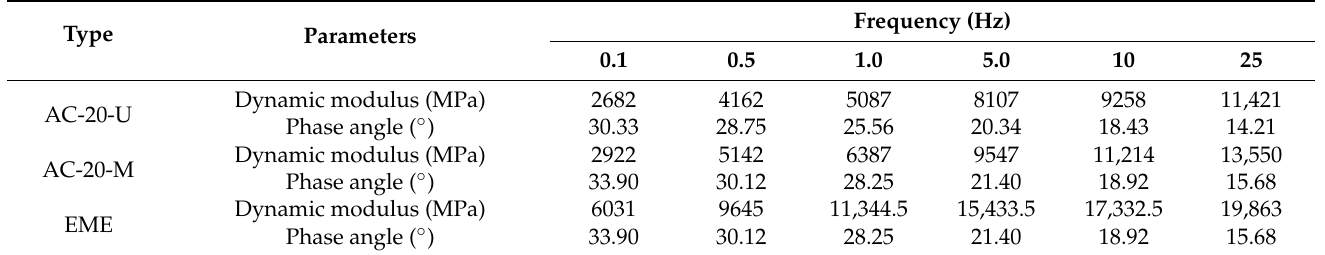
Table 4. Dynamic modulus and phase angle test results of the various asphalt mixtures.